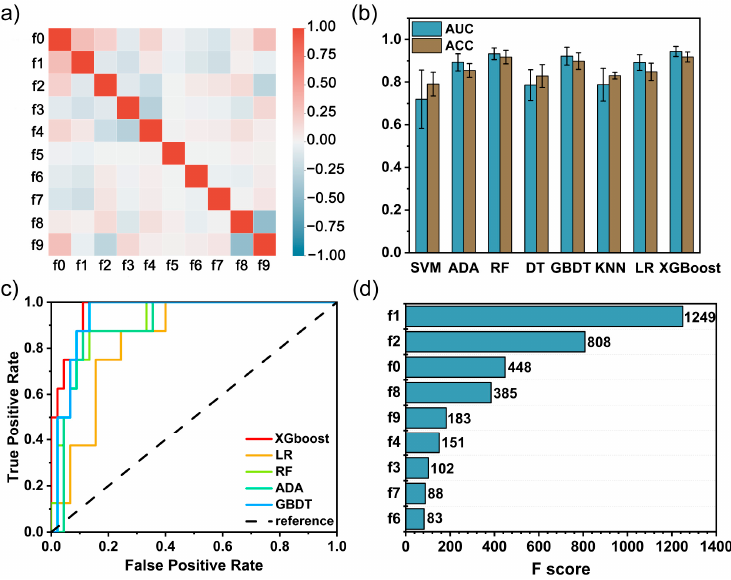
Figure 1. ( a ) The heat map of Pearson’s correlation coefficient matrix is among the ten features selected for the preparation of silica-coated GNRs. Feature names are listed in Table 1. ( b ) Prediction accuracy (ACC) and AUC values of various ML models. SVM: support vector machine; ADA: AdaBoost; RF: random forest; DT: decision tree; GBDT, gradient boosting decision tree; KNN, k-nearest neighbors; LR, logistic regression; and XGBoost: eXtreme gradient boosting. ( c ) ROC curves calculated with ADA, RF, GBDT, LR, and XGBoost models, respectively. ( d ) Importance scores of descriptors derived from the XGBoost model.